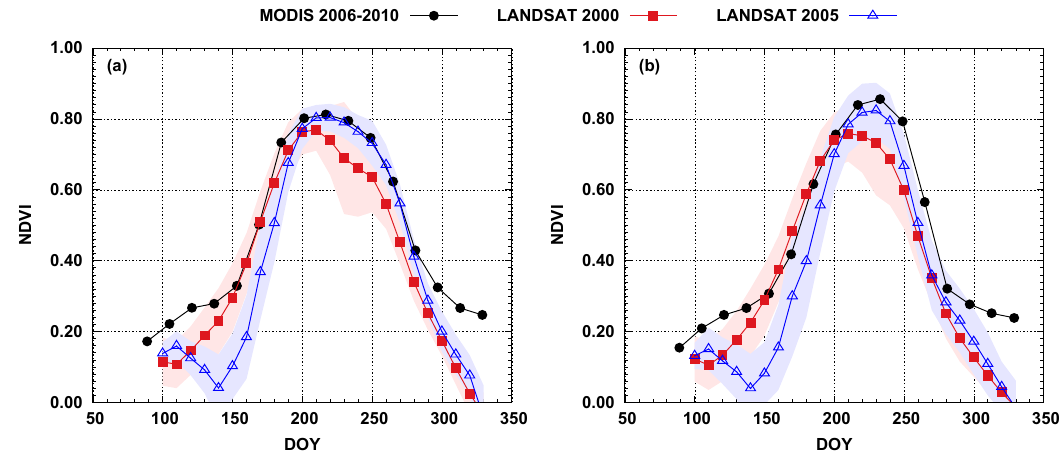
Figure 7. Comparison of the NDVI time series generated from five-year averaged state-wide Moderate Resolution Imaging Spectroradiometer (MODIS) [47] and from yearly processed LANDSAT for the Lower Bear Creek watershed for corn / maize ( a ) and soybeans ( b ). Filled curves represent one standard